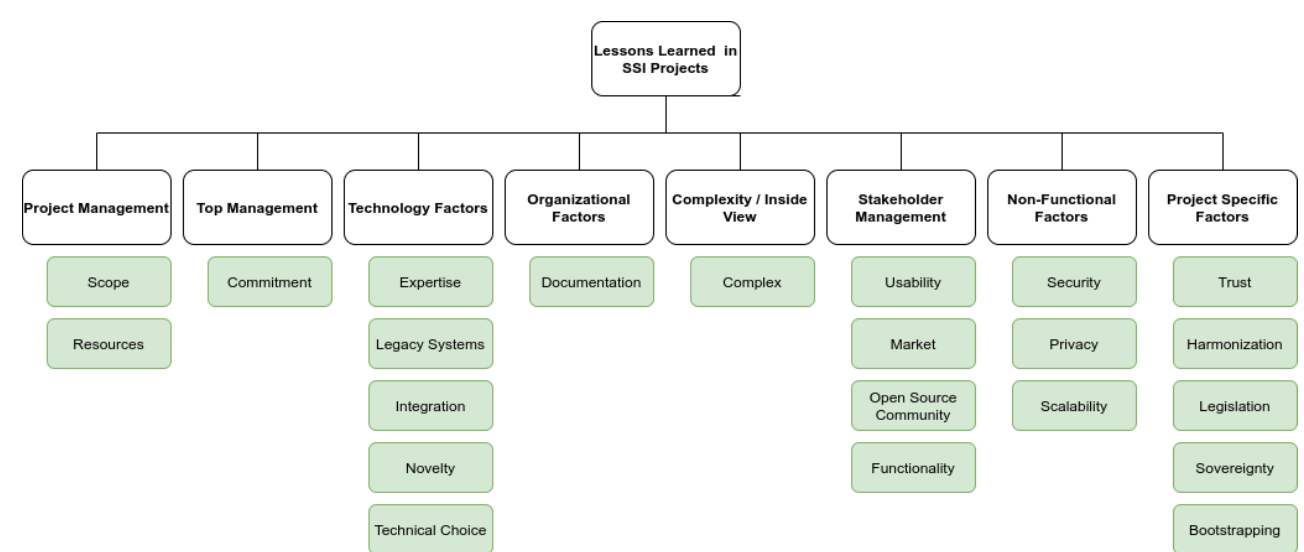
Figure 6. Taxonomy based on challenges in SSI